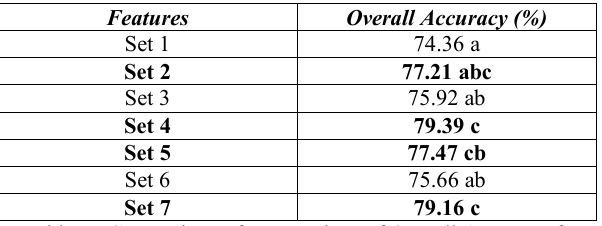
Table 5. Comparison of mean values of Overall Accuracy for the seven set of features